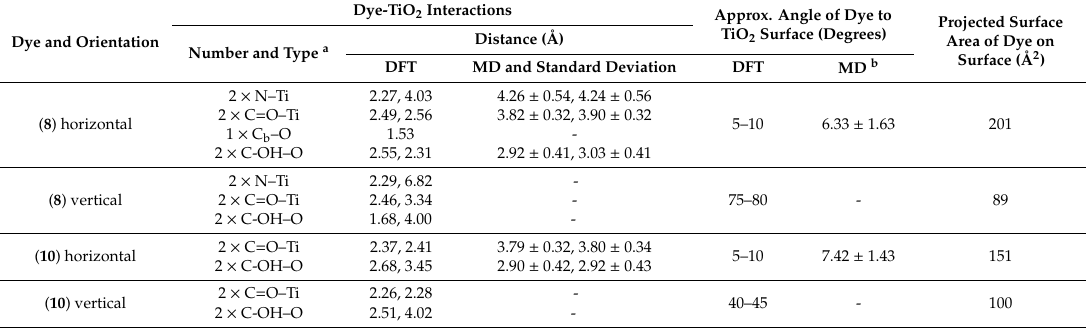
Table 3. The dyes; dye moieties and their interaction distances with the surface; approximate range of the angle of inclination of the dyes’ carbon backbone to the surface; the estimated projected surface area of the molecules on the surface based on their van der Waals outline. Dye-TiO 2 Interactions Approx. Angle of Dye to Projected Surface TiO 2 Surface (Degrees) Distance (Å) Area of Dye on Dye and Orientation a Surface (Å 2 )Number and Type DFT MD and Standard